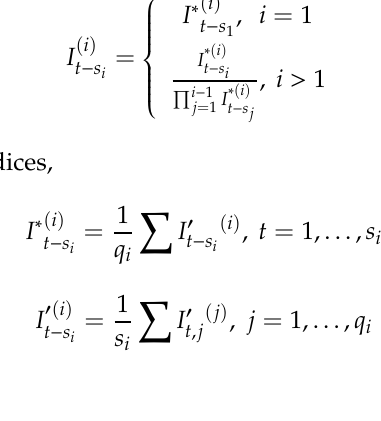
Overall and two periods method.